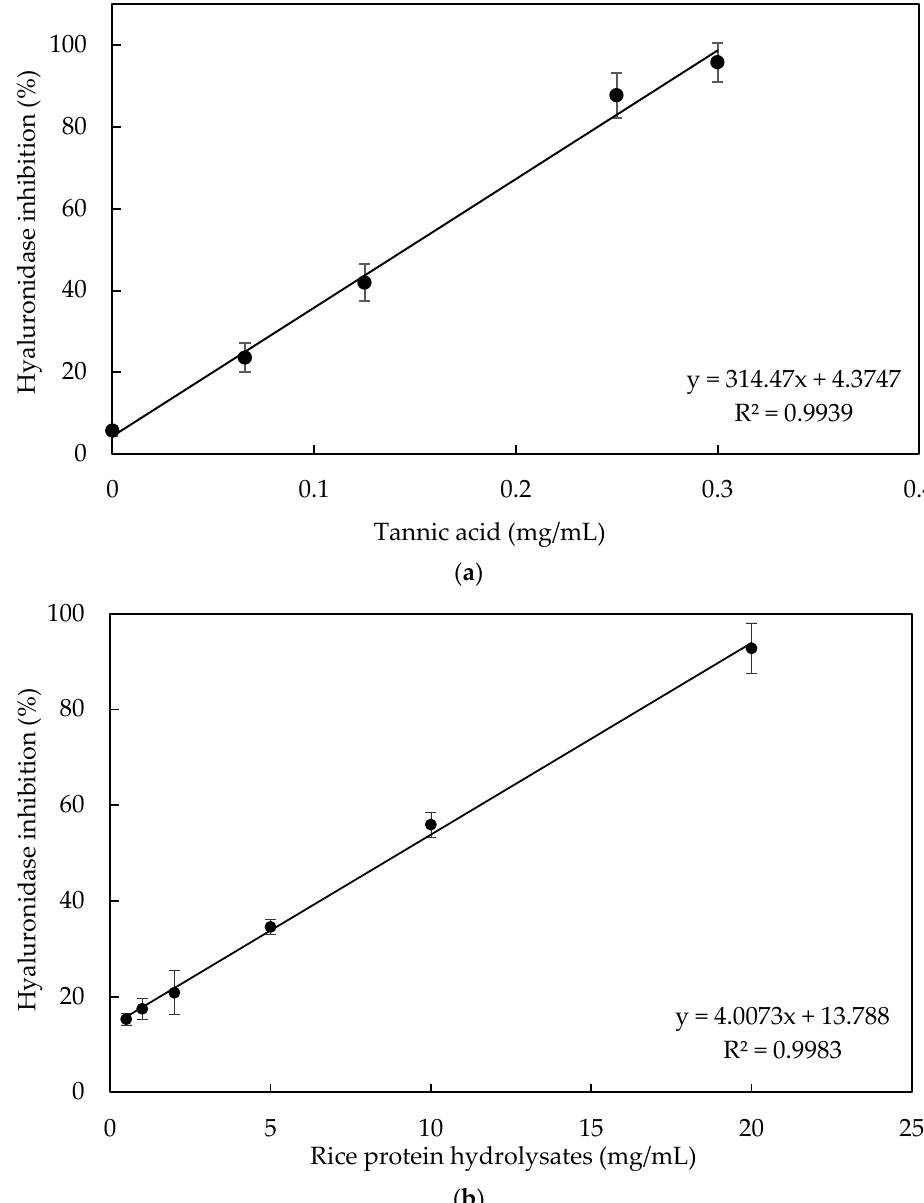
Figure 3. Hyaluronidase activity inhibition by different dilutions of ( a ) tannic acid (mg/mL) and ( b ) rice protein hydrolysate (mg/mL).